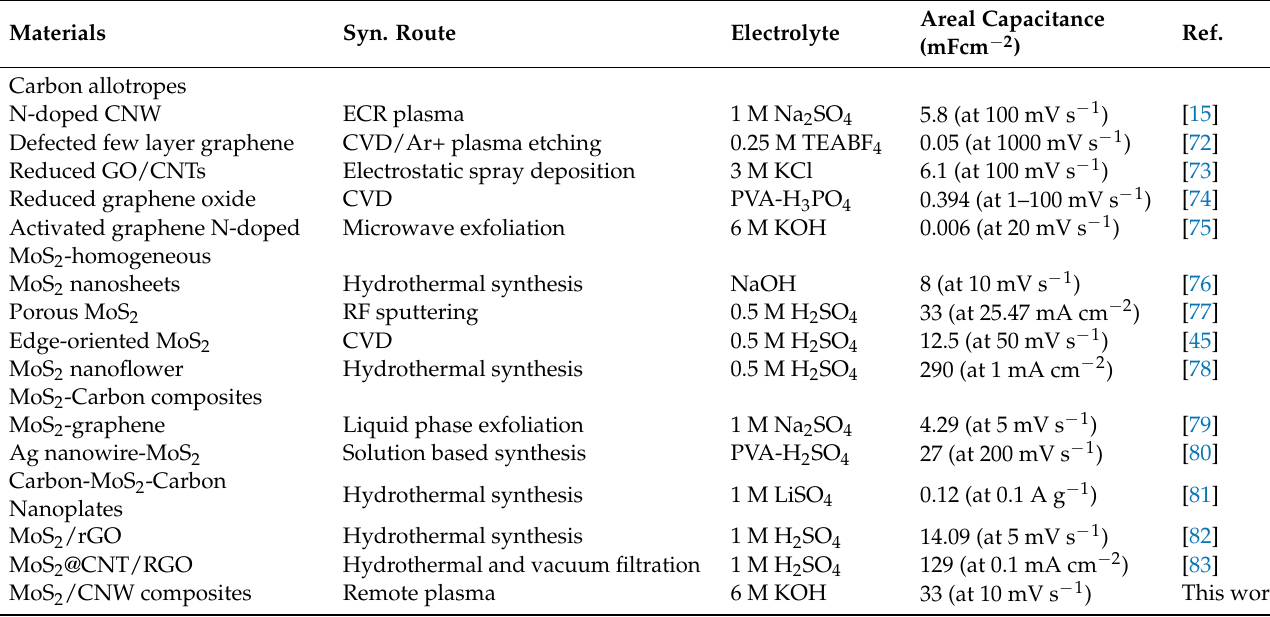
Table 1. Detailed information regarding EDLC